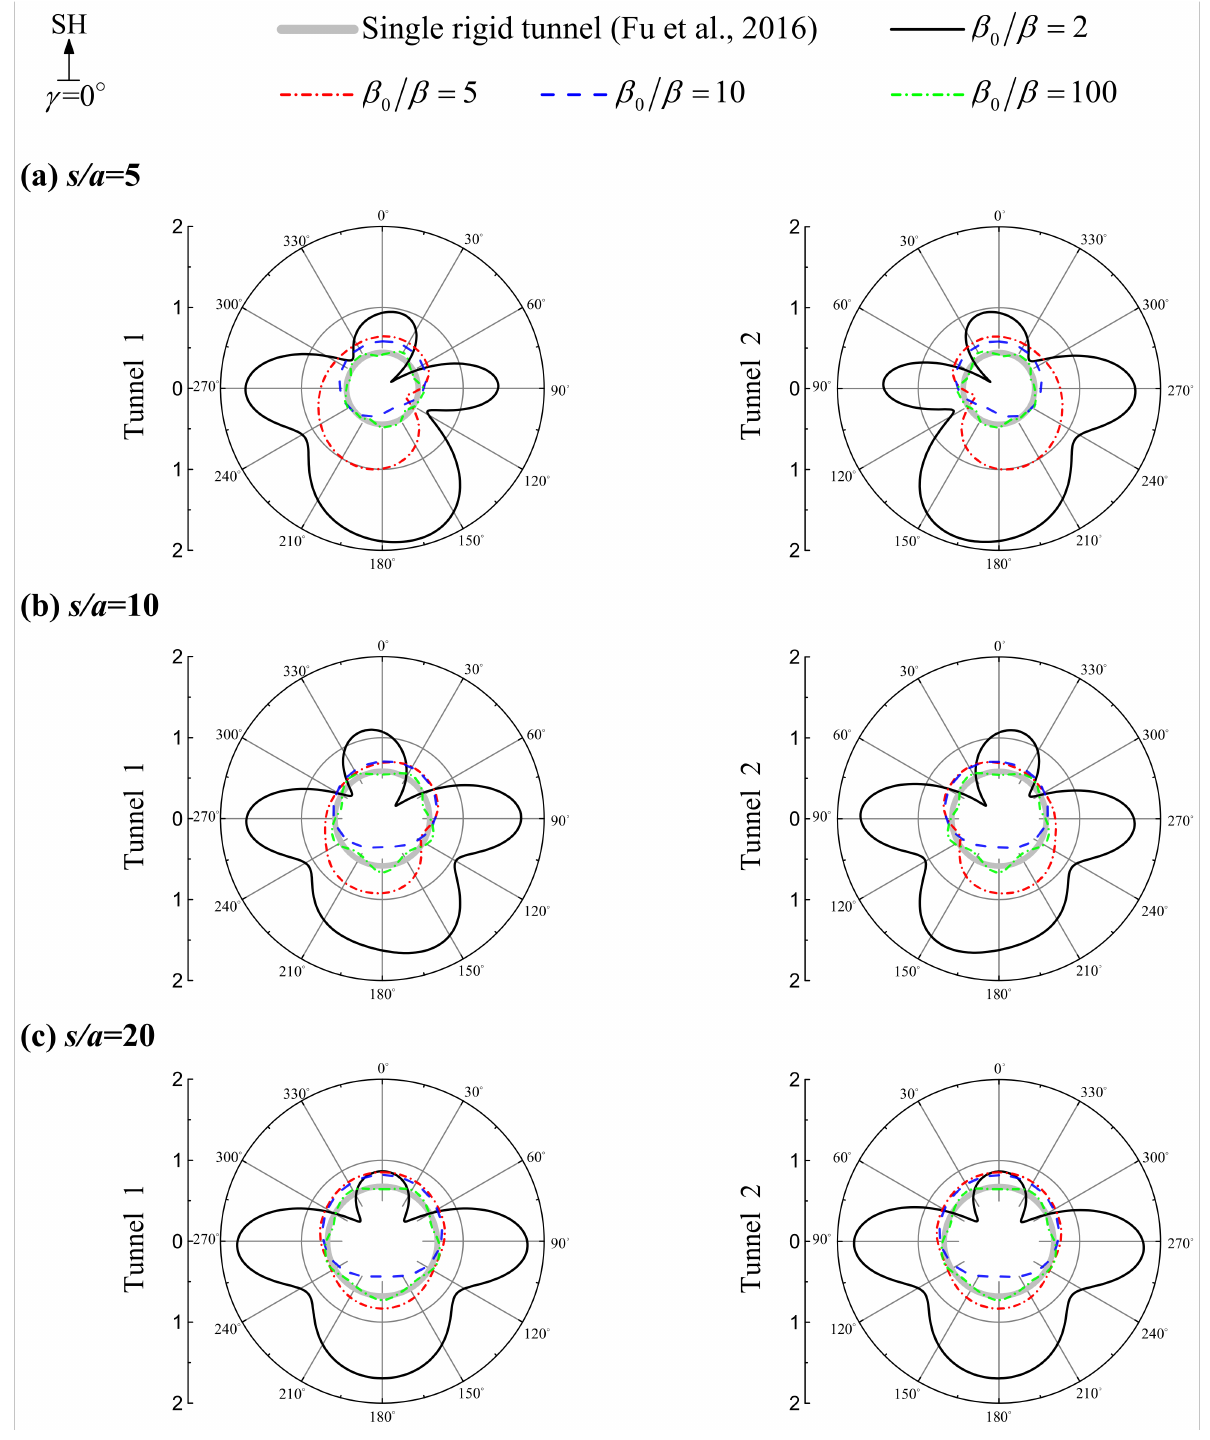
Figure 6. Typical spectral amplification of the tunnel displacement responses under different tunnel distance ( s / a ). Tunnel burial depth D / a = 2, dimensionless frequency η = 1.0, incident angle γ = 0 ◦ (vertical incident). Left column: tunnel 1; right column: tunnel 2. Parts ( a – c ) correspond to the tunnel distance s / a = 5, 10, and 20,